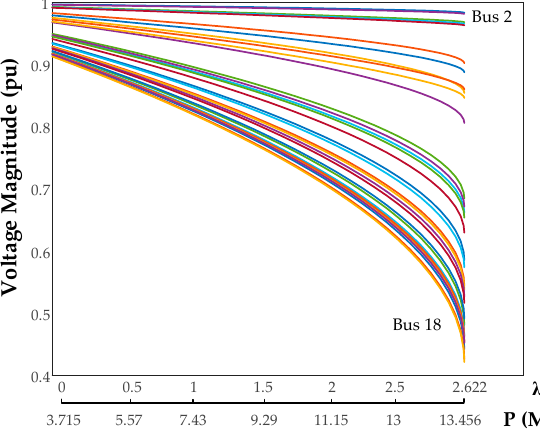
Figure 5. PV curve for the IEEE-33 radial system.